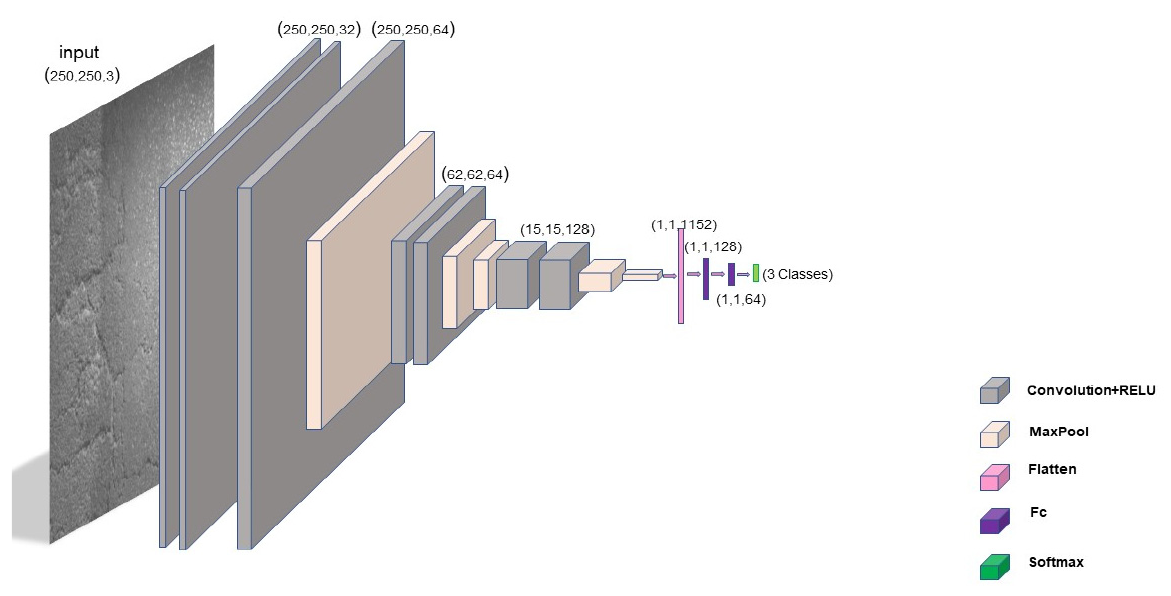
Figure 3. The proposed convolutional neural network (CNN) architecture.